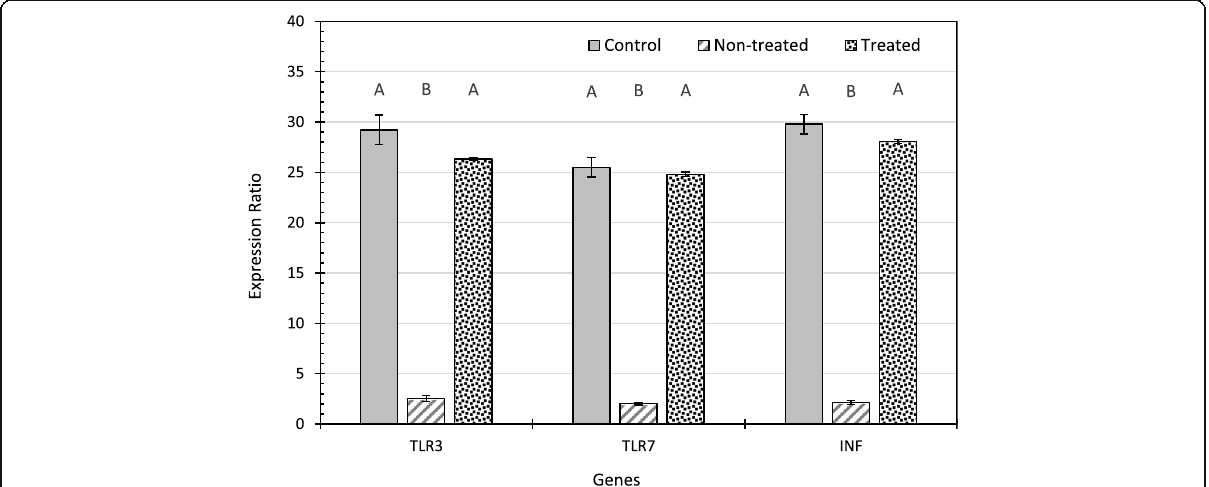
Fig. 3 The comparison of TLR3, TLR7, and IFN- α expression level in non-treated chronic HCV patients, treated HCV patients, and control subjects. Capital letters represent the significance among the groups. Error bars represent standard error